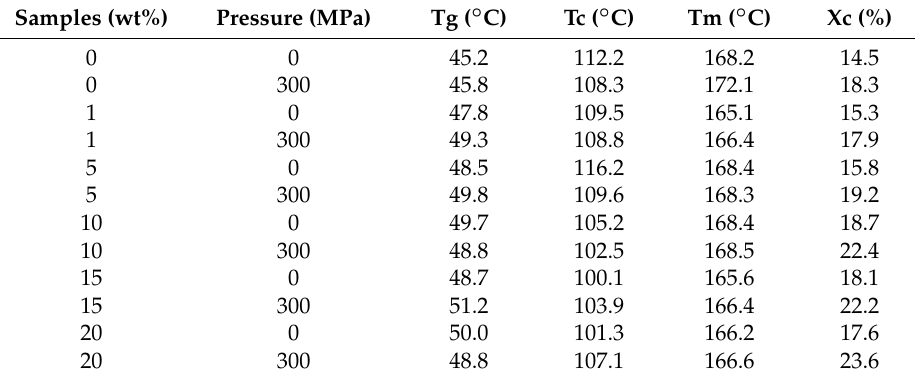
Table 2. Thermodynamic characterization of composite films.